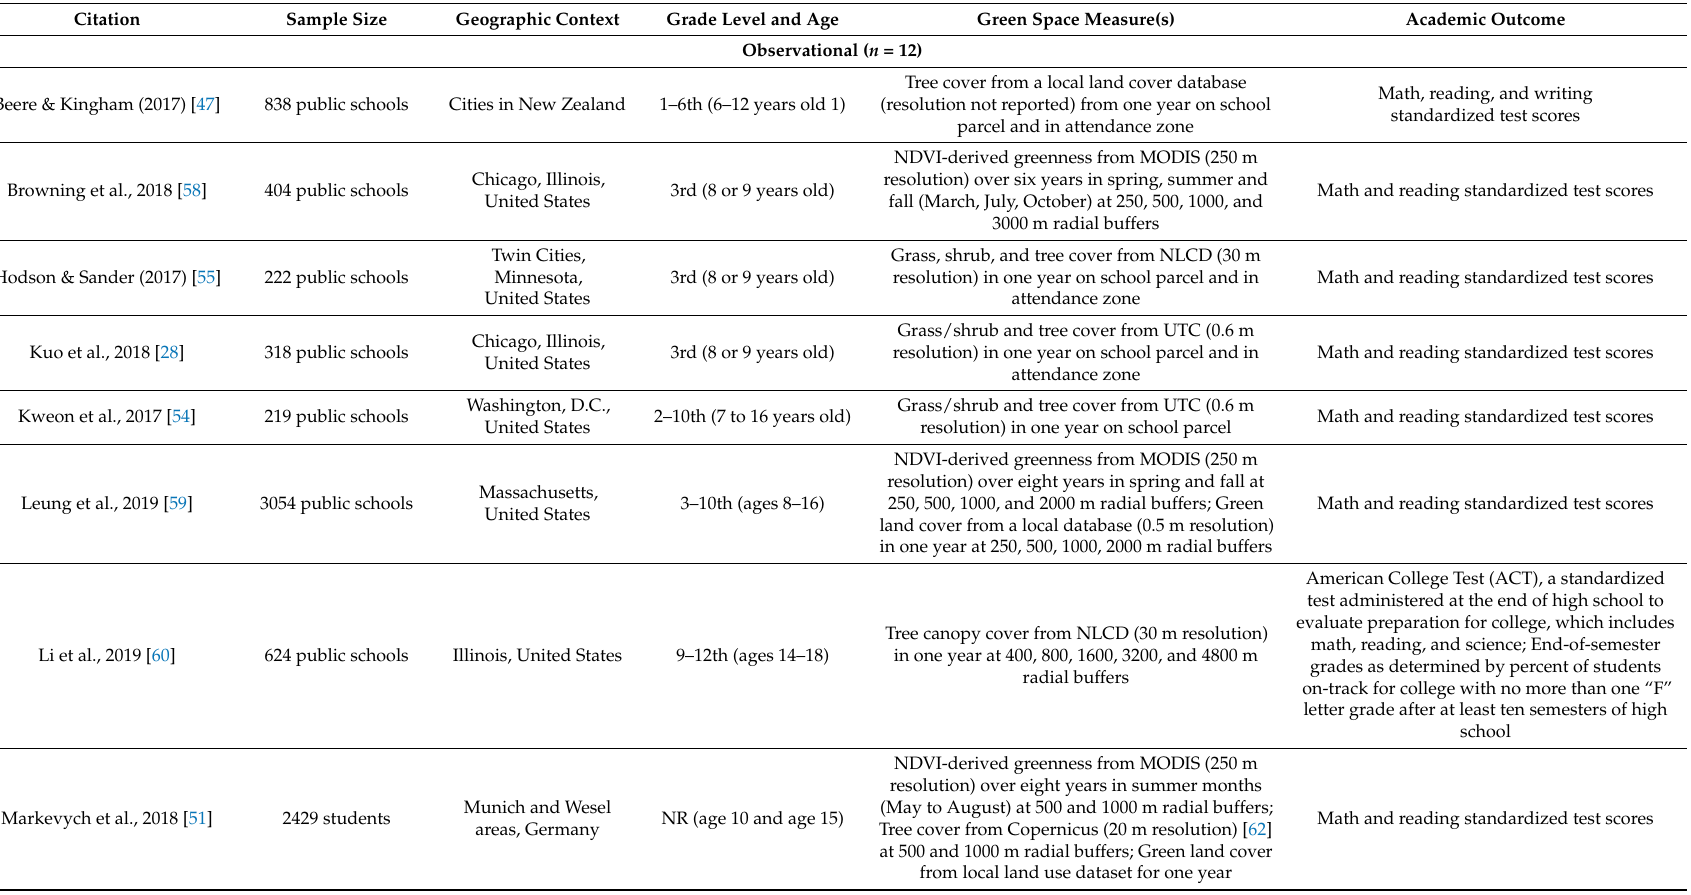
Table 2. Description of study sample, outcome, and green space measure stratified by research